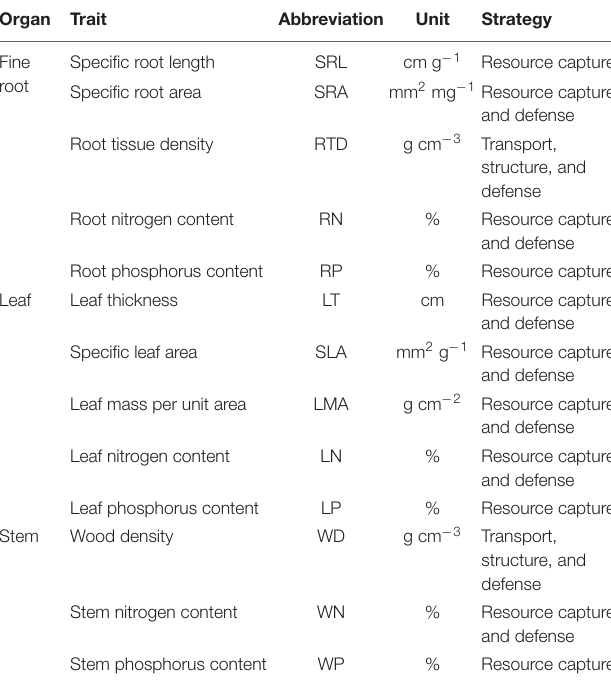
TABLE 1 | List of the 13 functional traits, as well as their ecological